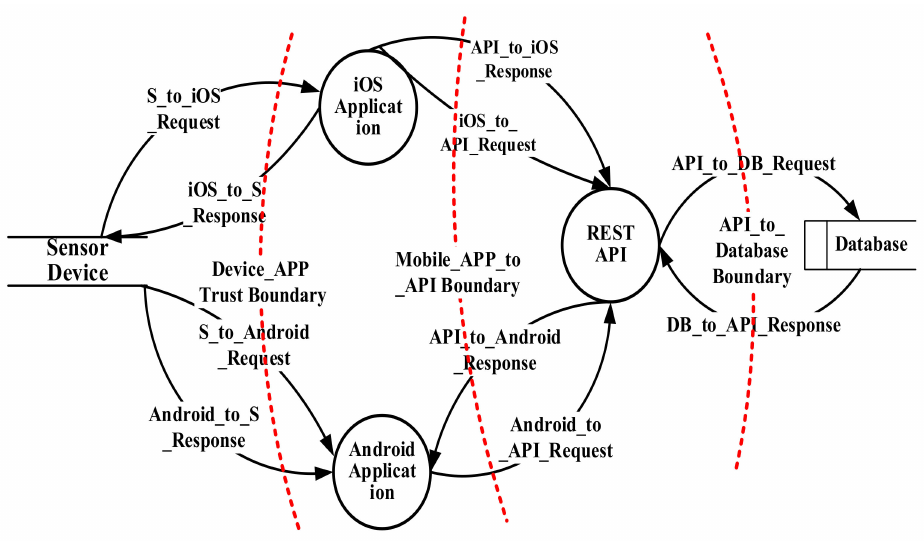
Figure 5. DFD diagram in Microsoft Threat Modeling